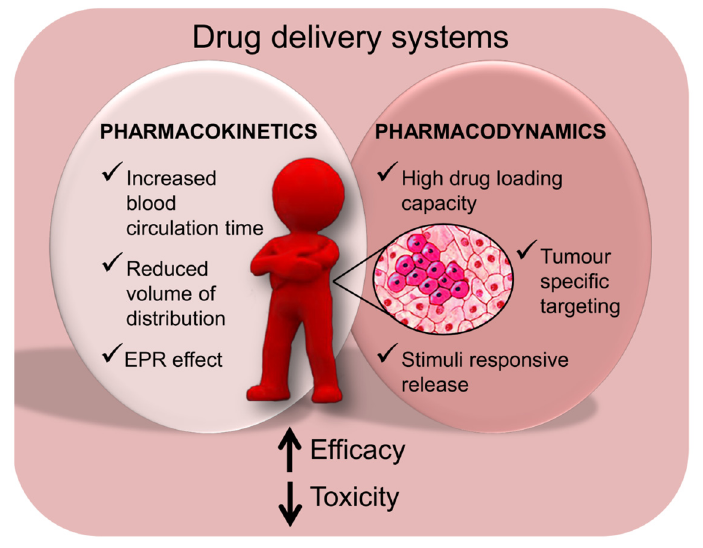
Figure 5. Advantages of chemotherapy agent conjugation with